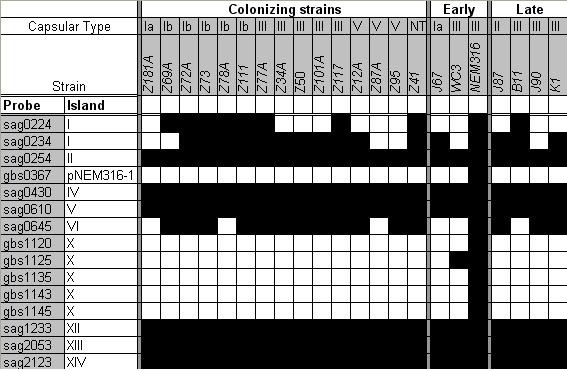
The presence of putative pathogenicity islands as defined by CGH.  Results of PCR (figure 3) and CGH (figure 4) analyses. The genes and GBS strains shaded grey in table 2 are those included in CGH experiments, table 3. Sag0001 encodes dnaA, a positive control for PCR. The NEM316 strain is a positive control. The pNEM316-1 plasmid is located three times in the NEM316 genome, and in figure 1 is represented as 'islands III, VII and VIII'. The strains are divided into three groups: colonizing strains from healthy pregnant women, and strains causing early- and late-onset sepsis in babies; and are sub-divided into those strains for which we have PCR results, and those for which we have PCR and CGH data.